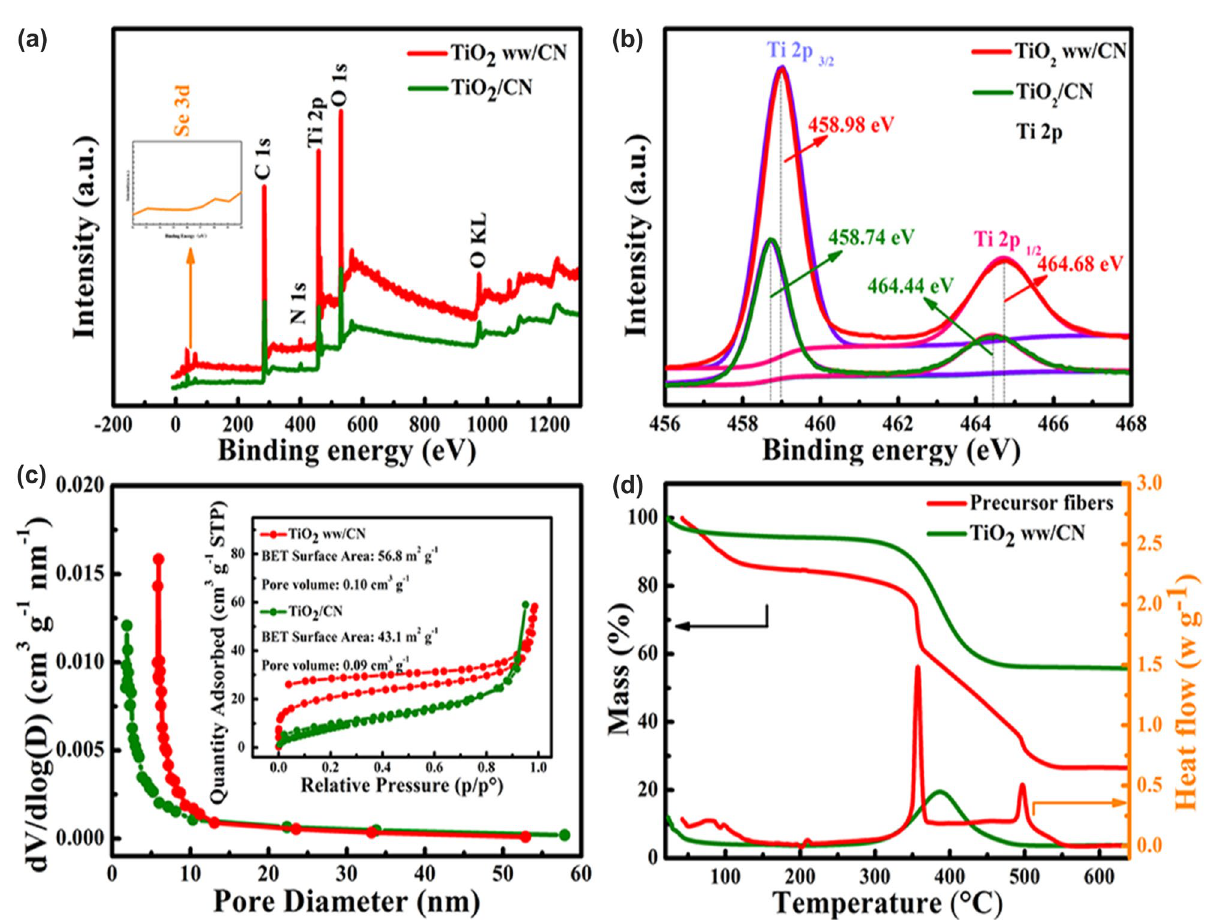
Fig. 2 a XPS survey spectrums, b the high-resolution Ti 2 p of TiO 2 ww/CN and TiO 2 /CN; c the pore volume distribution of both TiO 2 ww/CN and TiO 2 /CN, corresponding N 2 adsorption/desorption curves (inserted image); d TG and DTA of TiO 2 ww/CN and precursor fibers in air at a rate of 5 °C min